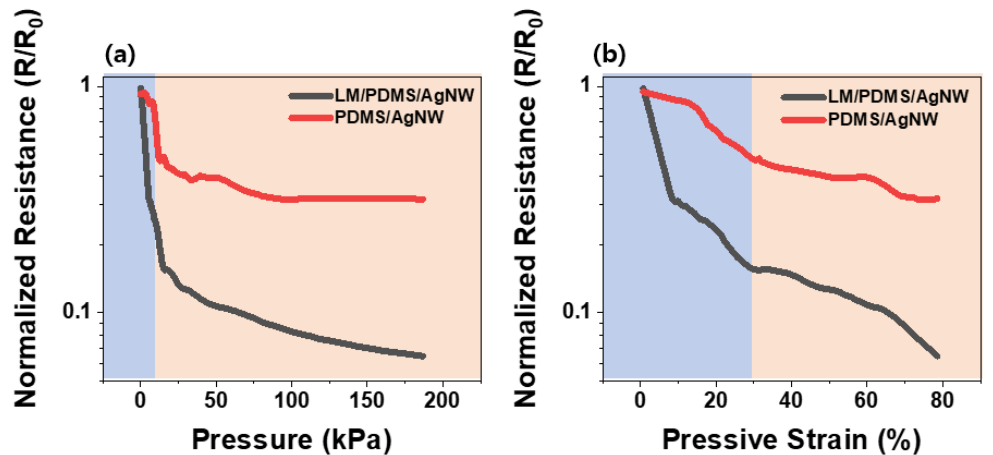
Figure 4. Normalized resistance of PDMS/AgNW (red) and LM/PDMS/AgNW (black) sponge sensors. ( a ) Normalized resistance versus pressure under applied pressure and ( b ) normalized resistance versus compressive strain under applied pressure. Blue region: contact zone. Orange region: piezoresistive zone.